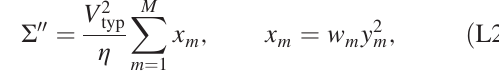
ffiffiffiffiffi p 30